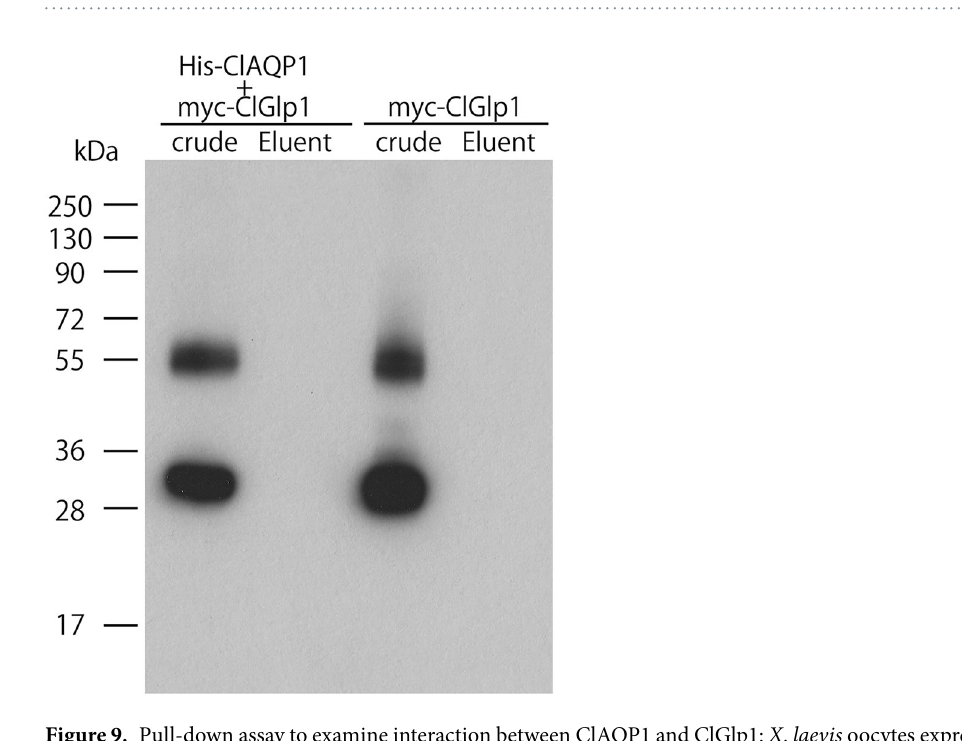
Figure 8. Effect of RNAi against ClBib on offspring production. Bugs with reduced ClBib expression oviposited significantly more eggs compared to GFP dsRNA-injected controls. The graph shows mean ± SEM.